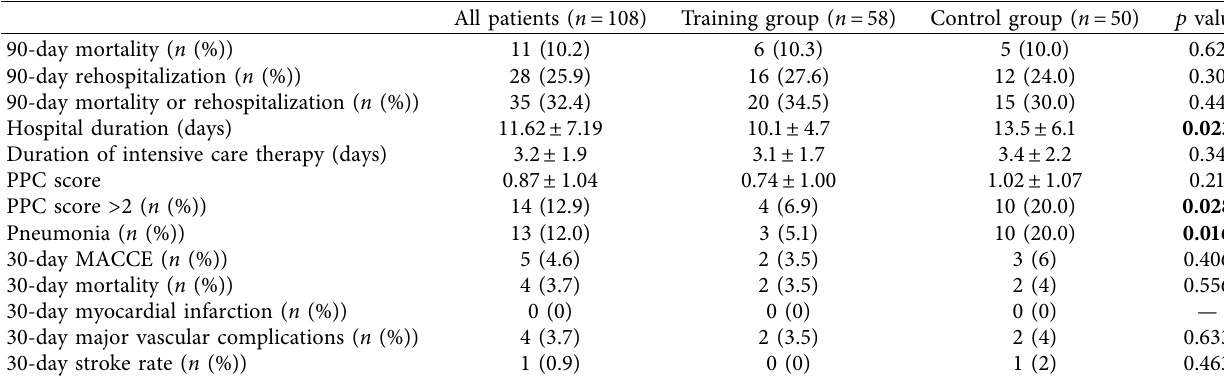
Table 3: Outcome measures.